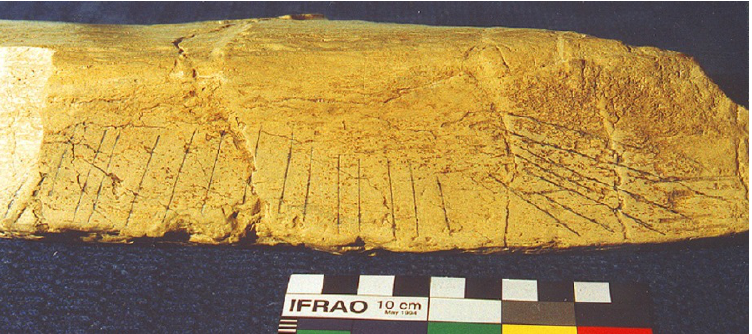
Figure 4. Deliberate engravings on a tibia fragment of the forest elephant from the major Lower Paleolithic occupation site near Bilzingsleben, north of Erfurt, Germany; one of several engraved pieces from the living floor of the Holstein